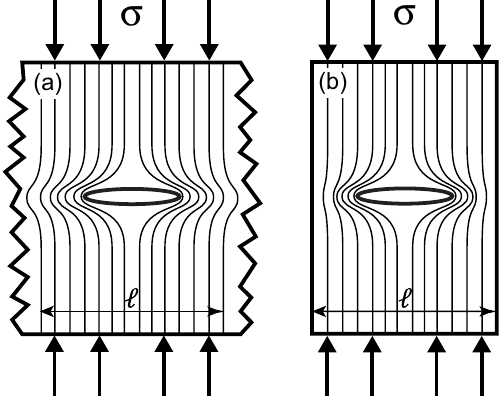
Figure 1. Stress concentration from edges. An infinite plate sub- ject to a remote compressive stress (a) compared to a finite plate (b) subjected to the same stress. The tighter spacing between the lines of force represents higher local stress. The oval in the center is the crack. Shown for scale is length ‘ . Adapted from Anderson